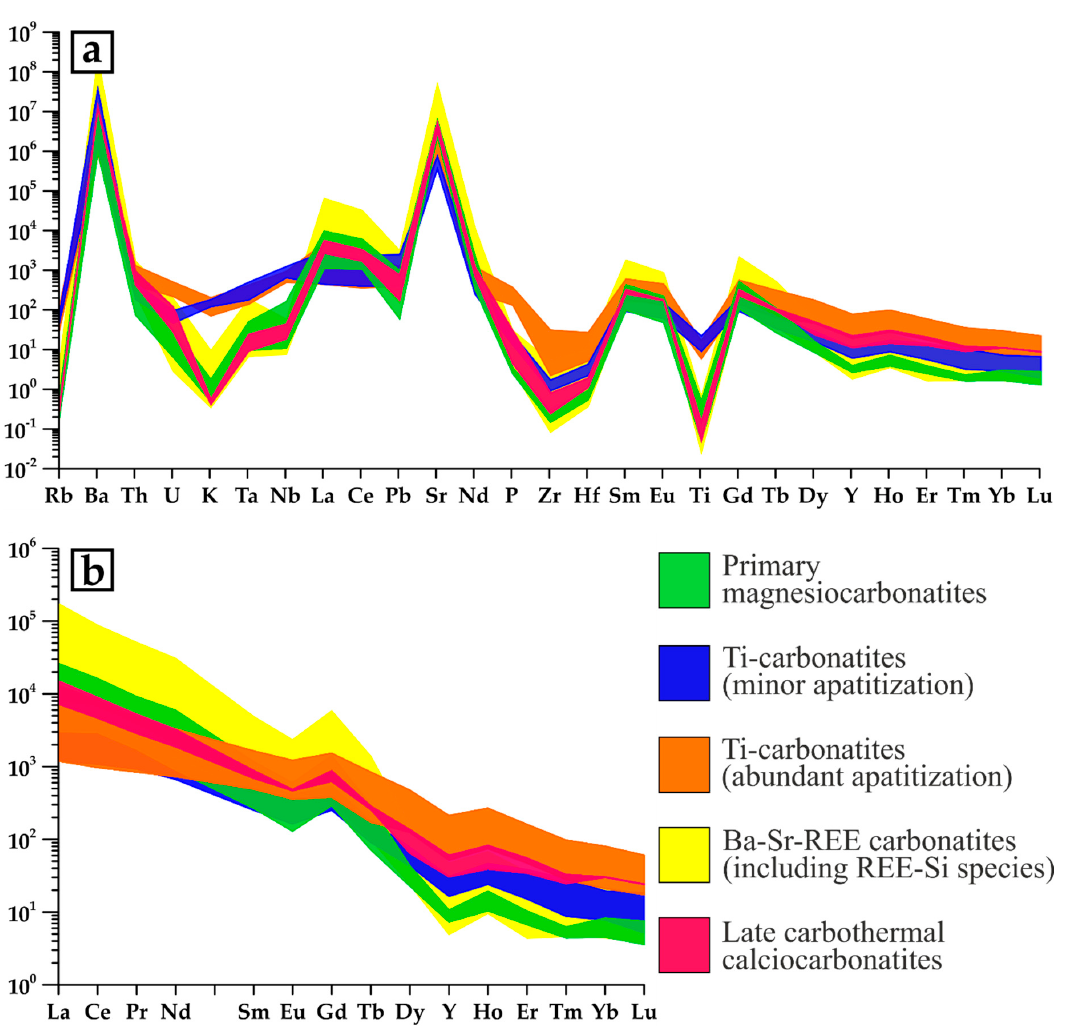
Figure 17. ( a ) Primitive mantle- and ( b ) chondrite-normalized plots for carbonatites of the Petyayan- Vara field. Normalization values from [114]. field. Normalization values from